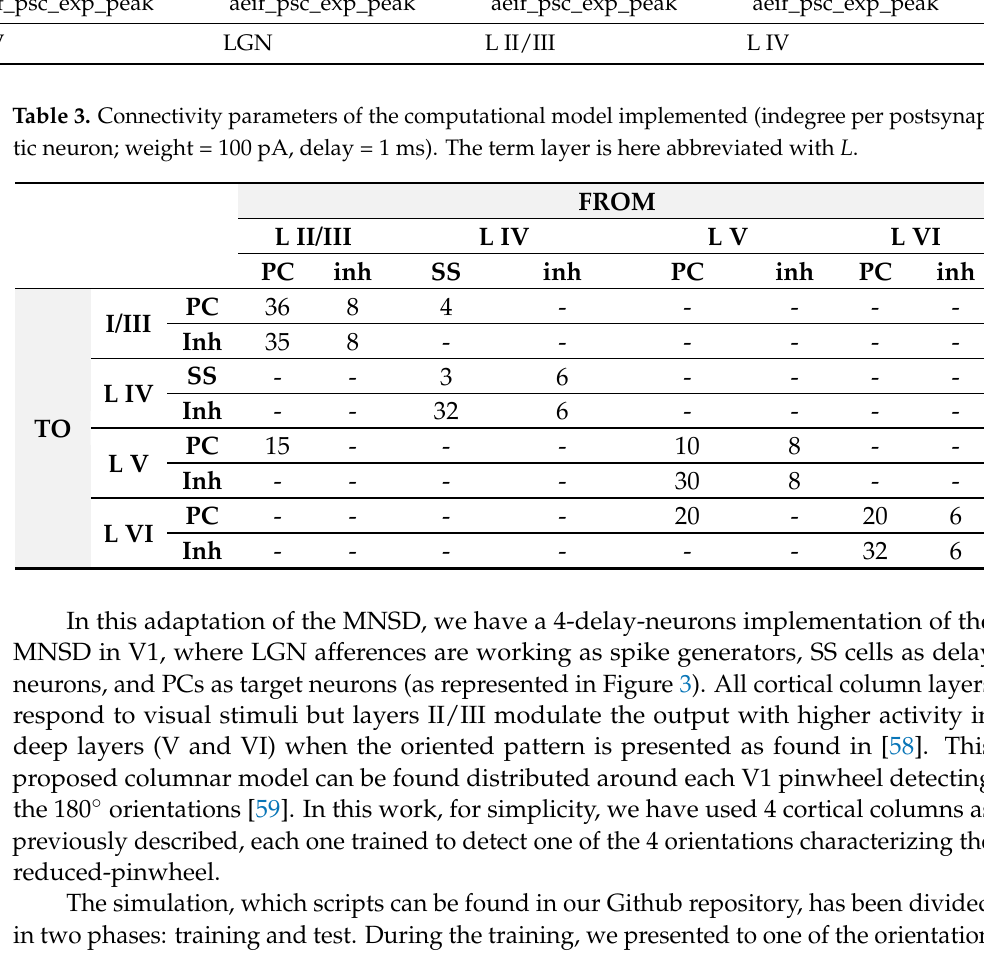
Population Size Model (excit.)